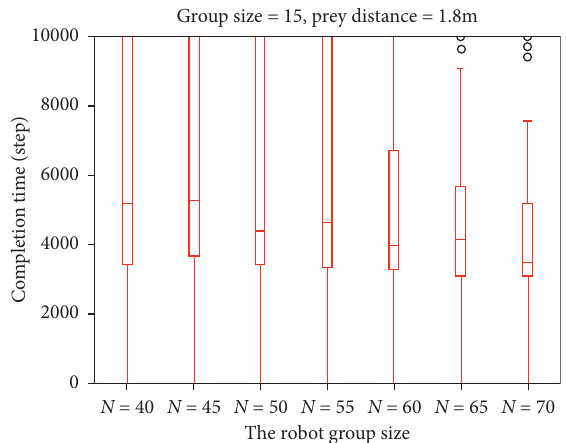
Figure 10: Box-and-whisker plots (Becker et al. 1998 [41]) of efficiency tests (100 observations per box) for seven robot group sizes in the maze arena. The boxes represent the interquartile ranges of the data, while the horizontal bars inside the boxes indicate the median values. The whiskers extend to the most extreme data points within 1.5 of the interquartile range from each box. The empty circles represent